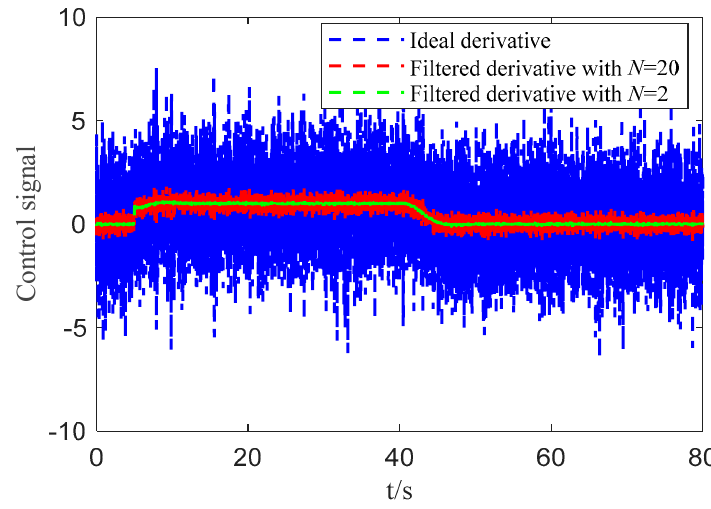
Figure 16. The control signal for Example 1 with high-frequency measurement noise.